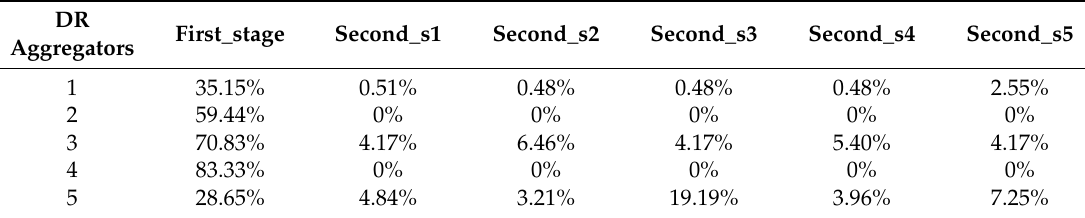
Table 9. Average absolute proportion of DR scheduled in each stage for each aggregator (five scenarios): With transmission